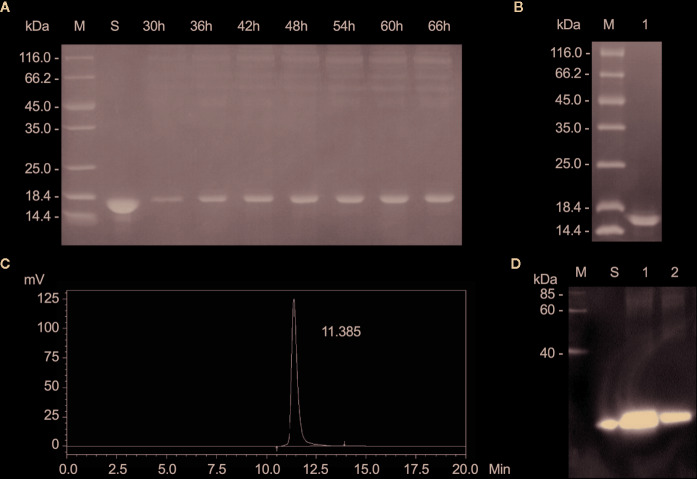
Relatively high purity of rLZ-8 protein was obtained after fermentation and purification process. (A) After 66 h fermentation, the position of rLZ-8 protein band was detected by SDS-PAGE in the supernatant, M: Marker, S: rLZ-8 protein standard, Lane 3-9: 30-66 h fermentation broth supernatants. (B) The purified rLZ-8 protein was detected by SDS-PAGE, M: Marker, Lane 1: purified rLZ-8 protein. (C) The purity was detected by HPLC. The only highest peak appeared at 11.385 min, and the purity was 99.89%. (D) Purified rLZ-8 protein and rLZ-8 protein standard was detected using Western blotting analysis, M: Marker, S: rLZ-8 protein standard, Lane 1: purified rLZ-8 protein sample 1, Lane 2: purified rLZ-8 protein sample 2.